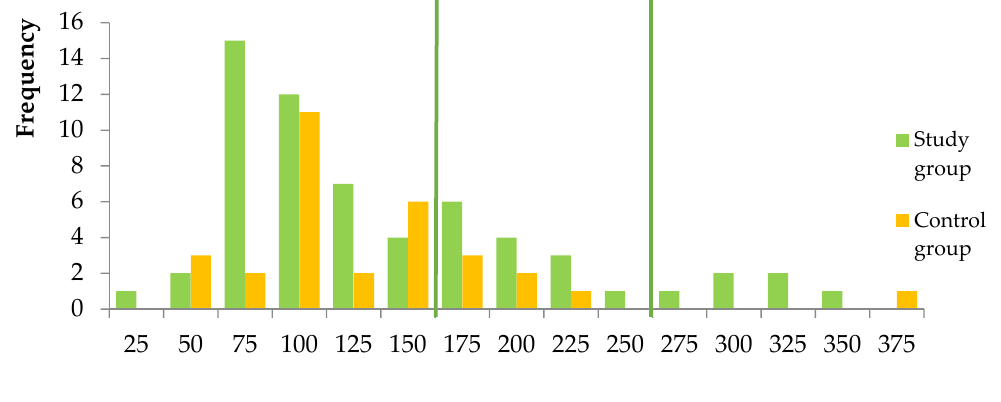
Figure 3. Histogram of the number of women with different levels of urinary iodine concentration.